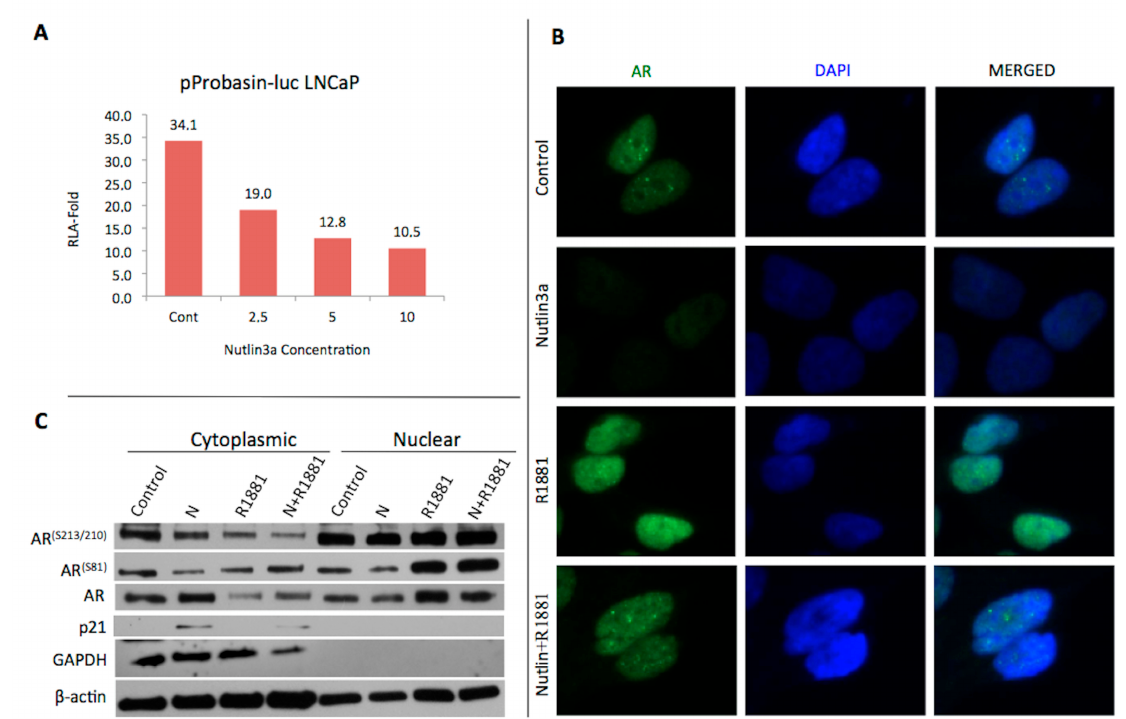
Figure 1. ( A ) Dose dependent decrease in AR transcriptional activity is observed in nutlin3a treated cells. ( B ) AR localization in Nutlin3a (2.5 µM, 24 h) treated LNCaP cells with the presence (10 nM, 24 h) and absence of androgens. ( C ) Cytoplasmic-nuclear fraction. LNCaP cells were treated Nutlin3a (2.5 µM, 24 h) and/or androgens (10 nM, 24